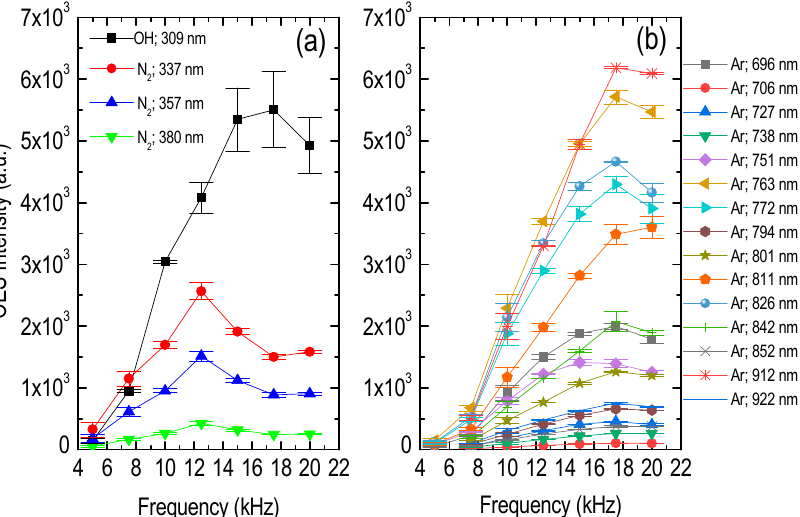
Figure 5. Optical emission intensity of the main emissive species detected as a function of the applied voltage frequency. ( a ) N 2 and OH species. ( b ) Ar species. Operational conditions: 11 kV pp and 1.5 slm. Mean values and standard deviations are calculated from two series of experiments carried out on different dates.